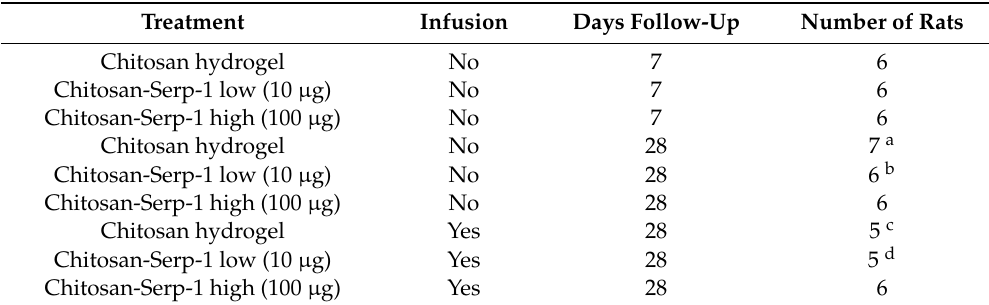
Table 1. Numbers of rats used in this